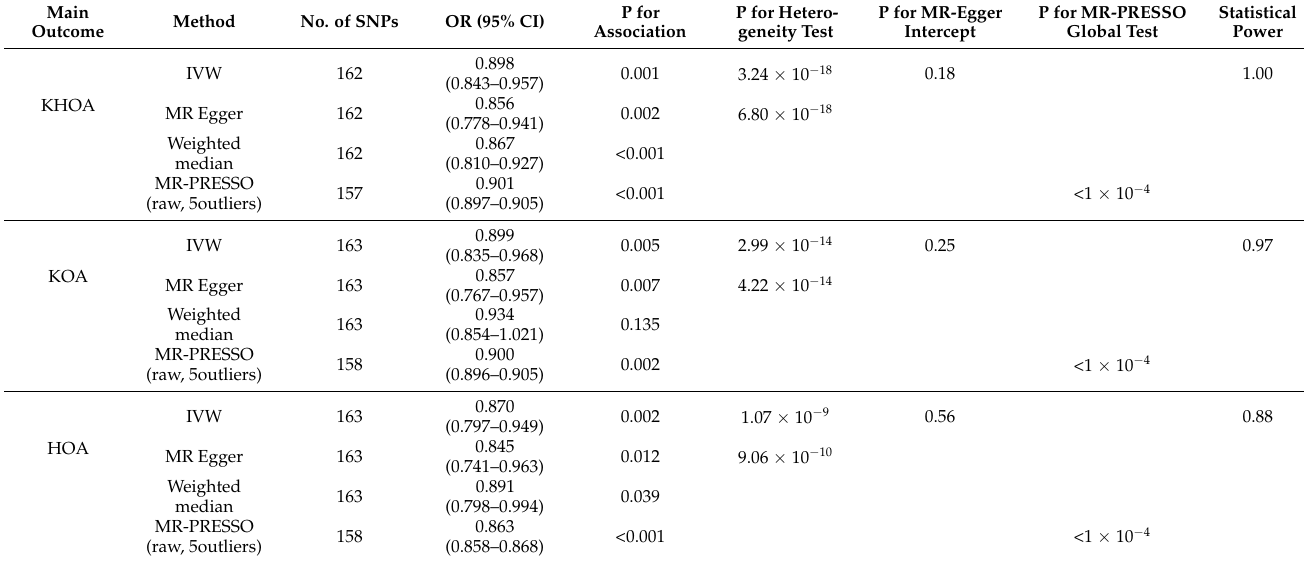
Table 3. Associations of genetically predicted LDL with OA risks in MR